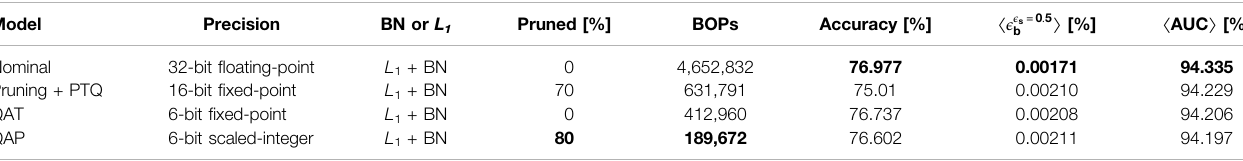
TABLE 1 | Performance evolution of the jet substructure classi fi cation task for this NN architecture. Model